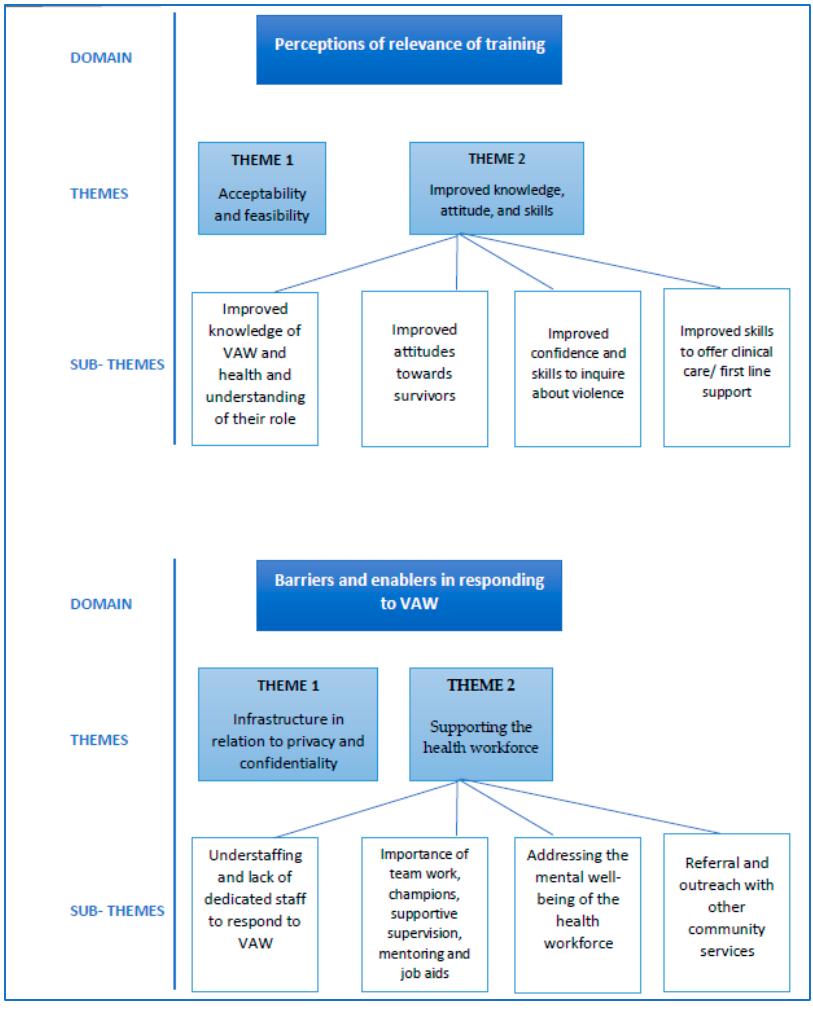
Figure 1. Objectives, themes, and sub ‐